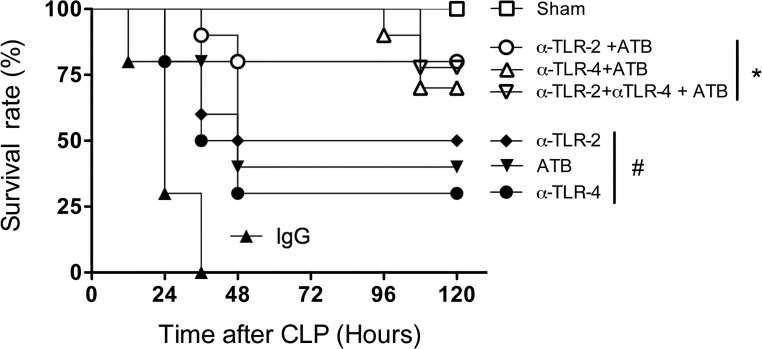
Combined effects of anti-TLR2, anti-TLR4 and antibiotics in polymicrobial sepsis.Mice were therapeutically treated with anti-TLR2, anti-TLR4 and antibiotics (metronidazole and ceftriaxone) separately or concomitantly 3 hours after the CLP procedure. The negative control isotype IgG antibody treatment was used as a control. n = 9–10 in each experimental group. * p<0.001 between use of the antibodies plus antibiotics and isotype IgG control and p<0.05 between individual use of antibodies or antibiotics. # p<0.05 between individual antibodies or antibiotics use and isotype IgG control. There was no difference in survival rates between mice given antibodies and antibiotics and the sham group (n = 10 animals/group). Antibody doses (1 mg/animal).